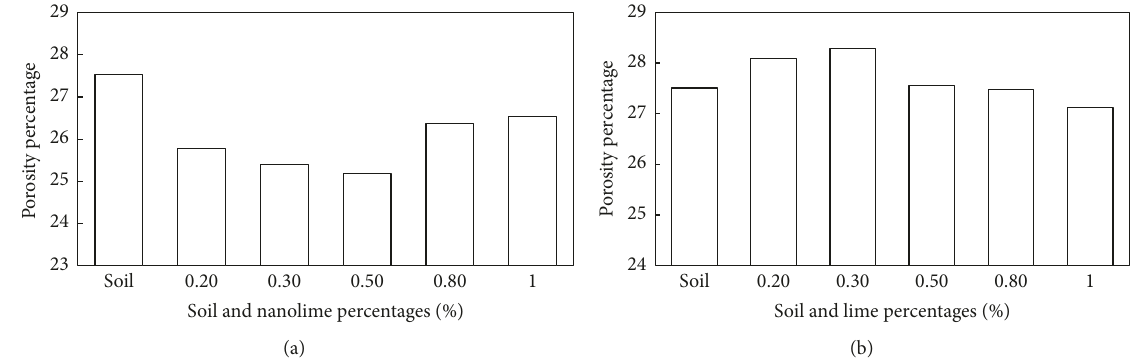
∗ Optimum water content of untreated soil. ∗∗ Remolded water content.